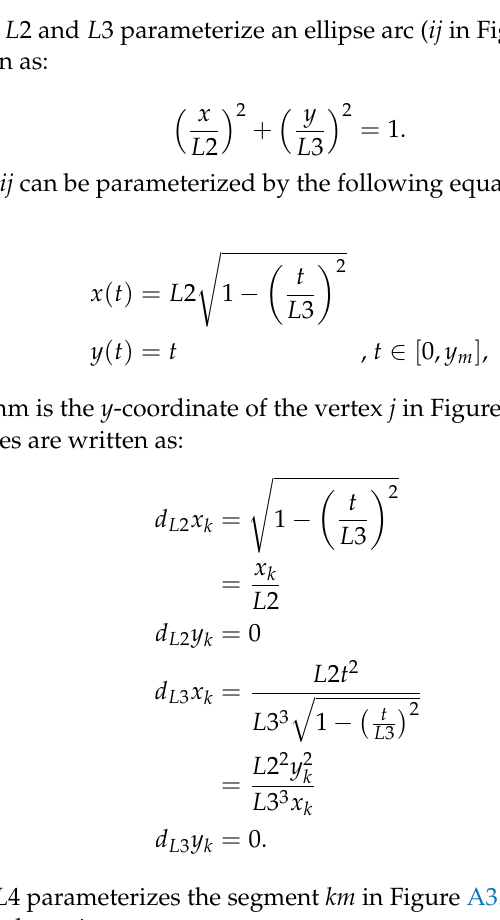
Figure A3. Molds of the die press (design